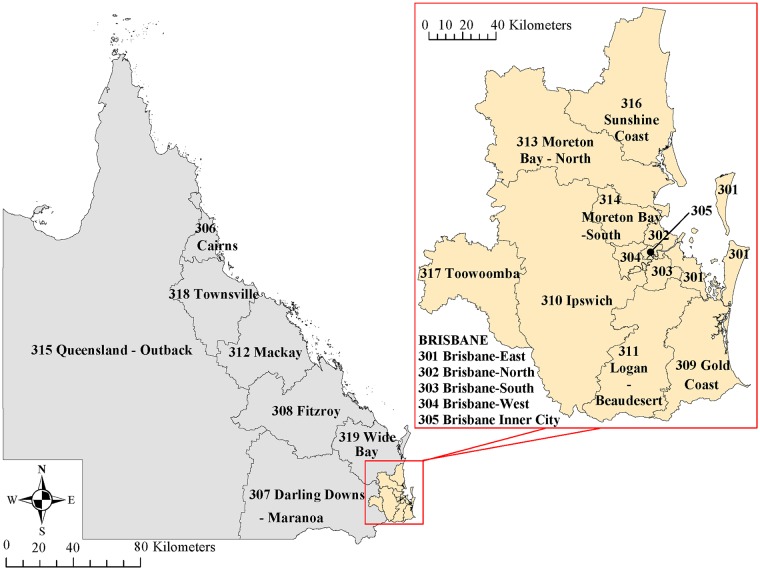
Map of Queensland divided into statistical areas level 4.